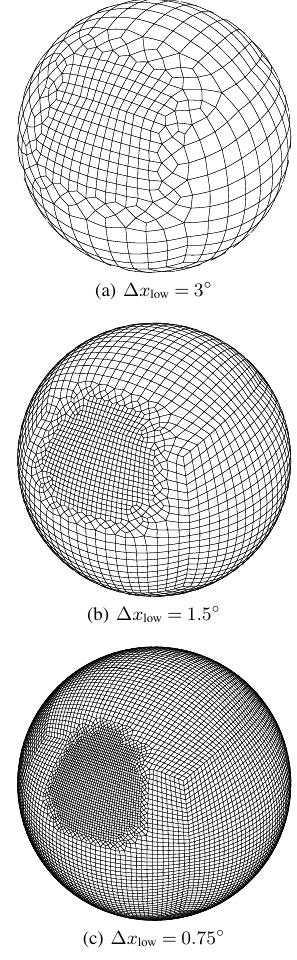
Figure 3. A family of × 2 grids with (from left to right) (cid:49)x low = 3, 1 . 5, and 0 . 75 ◦ , (cid:49)x high = (cid:49)x low /